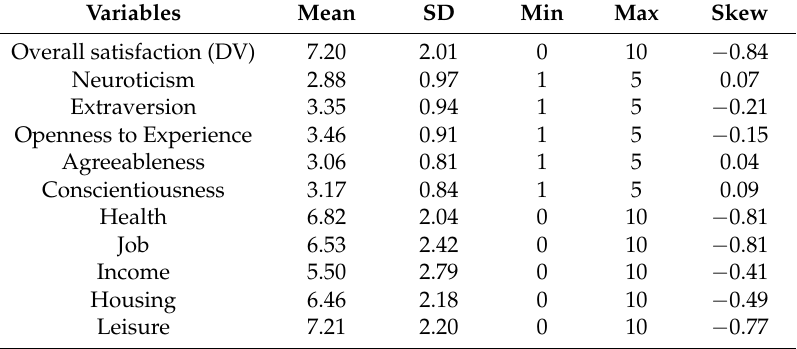
Table 1. Mean, standard deviation, minimum, maximum, and skew values of personality (BFI-10) and satisfaction variables for Survey 1; DV = Dependent variable. ( N = 40,297 except for variable job: N =